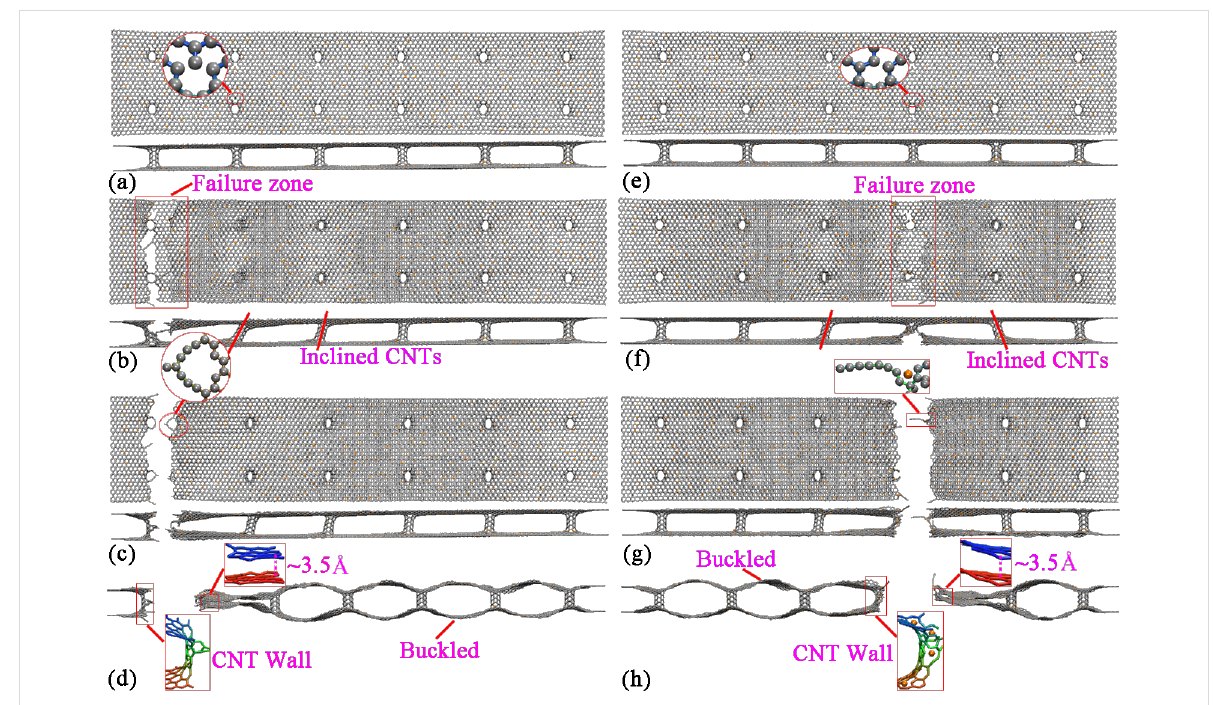
Figure 6: Atomic configurations of GNHS-2.5%B at the strain of: (a) 0.094; (b) 0.102; (c) 0.103, inset reveals the formation of a monatomic ring; (d) 0.104. Atomic configurations of GNHS-3%B at the strain of: (e) 0.099; (f) 0.106; (g) 0.107; (h) 0.108.